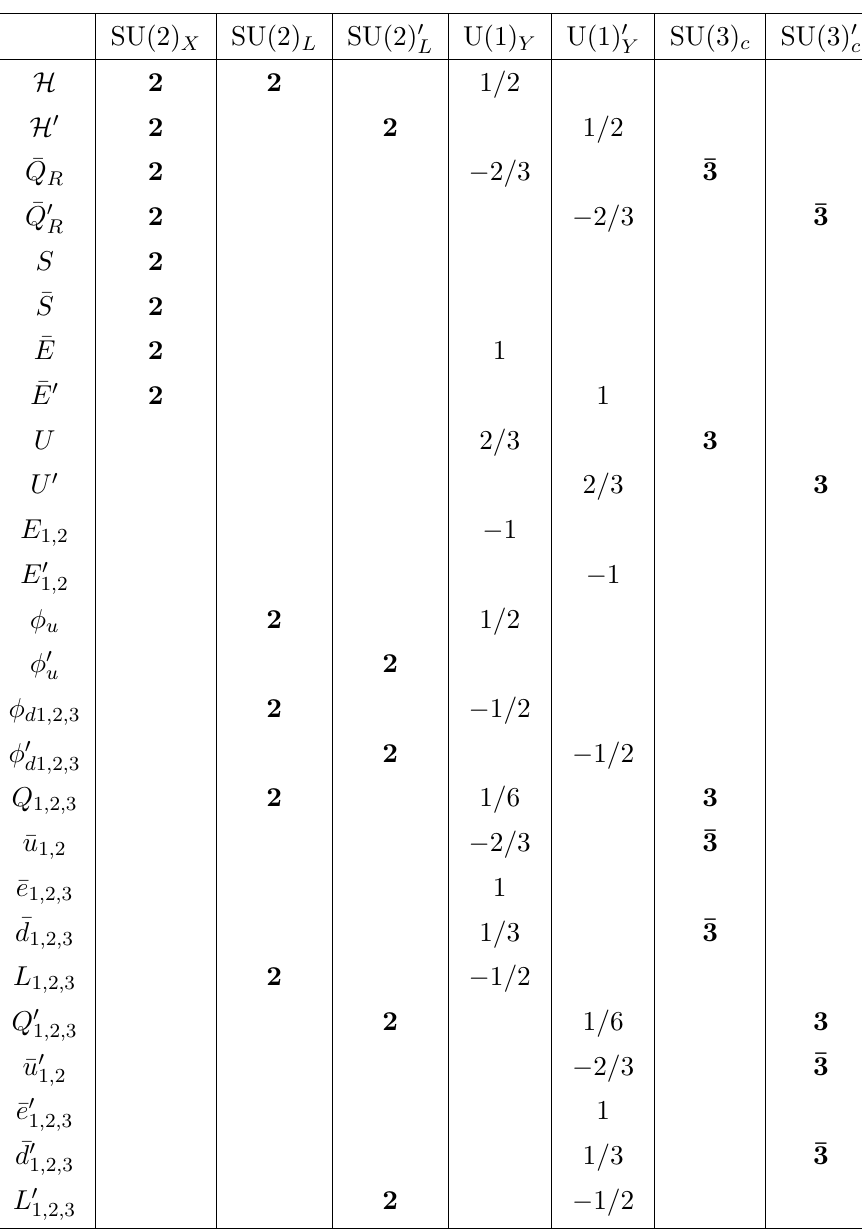
Table 1 . The matter content of the